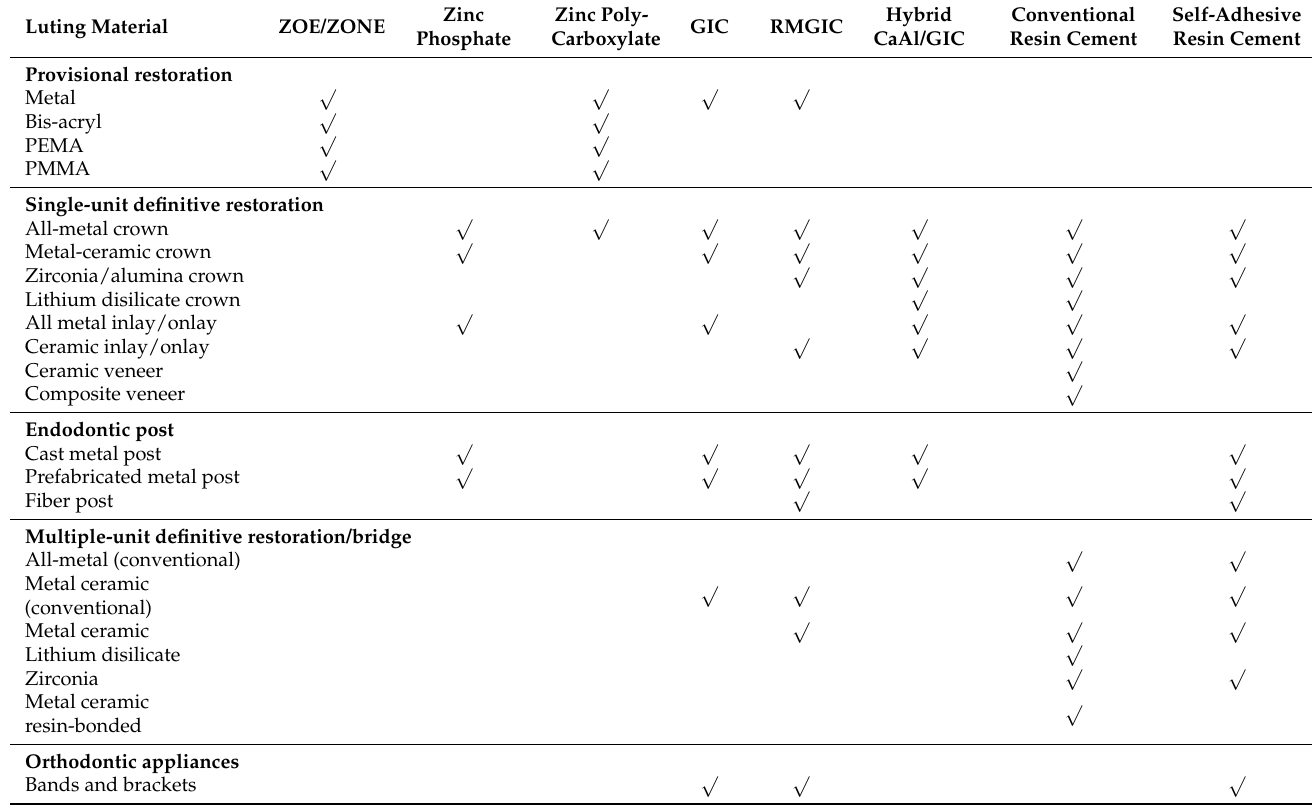
Table 3. Suggested clinical uses of luting